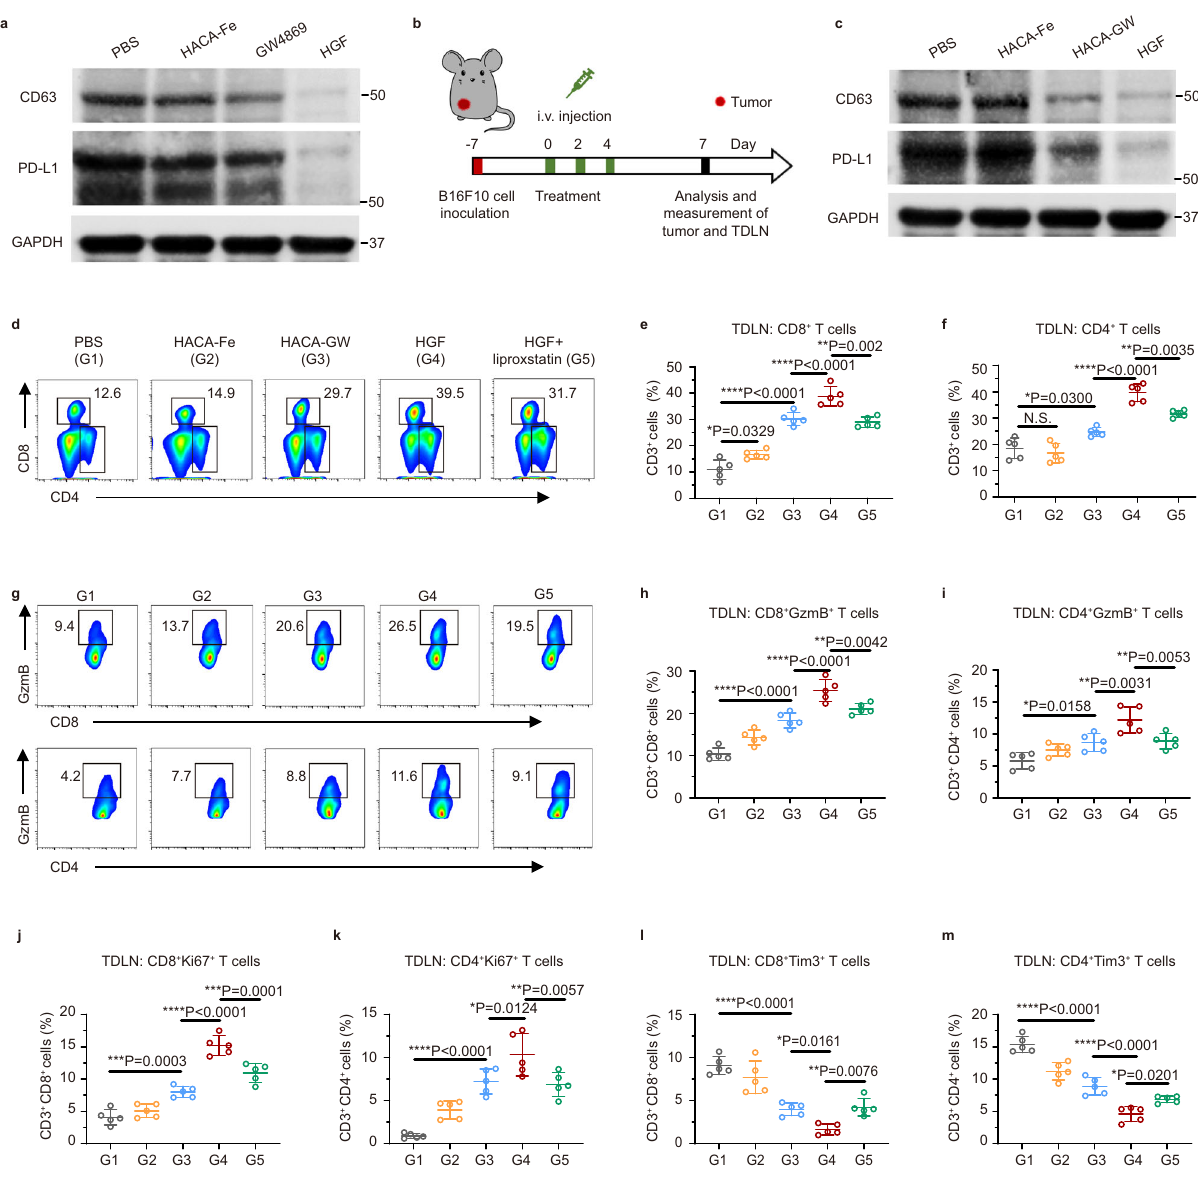
Fig. 3 HGF NPs inhibited exosomal PD-L1 and triggered robust immunostimulation. a Western blot analysis of exosome marker CD63 and PD-L1 via collecting the exosomes from the cell-free media of B16F10 cells with various treatments. GAPDH served as a loading control. Images were representative of the three experiments. b Scheme of in vivo experimental design for ( c – m ). C57BL/6 mice were subcutaneously inoculated with 1 × 10 6 B16F10 cells. When tumor volumes reached ~ 100 mm 3 , mice were treated with PBS, HACA-Fe, HACA-GW, or HGF on day 0, day 2, and day 4. Tumor and tumor- draining lymph node (TDLN) were collected on day 7 for further analysis. c Western blot analysis of exosome marker CD63 and PD-L1 in tumor tissues after treatment. Images were representative of the three experiments. d – f Flow cytometric plots ( d ) and quanti fi cation of CD8 + ( e ) and CD4 + ( f ) T cells, respectively, gated by CD3 + T cells in the TDLN ( n = 5) in groups of PBS (G1), HACA-Fe (G2), HACA-GW (G3), HGF (G4), and HGF + liproxstatin (G5). g – m Flow cytometric analysis of granzyme B + (GzmB + , g - i ), Ki67 + ( j and k ), and Tim3 + ( l and m ) in CD8 + and CD4 + T cells. n = 5 biologically independent animals per group. Data were presented as mean ± SD. Statistically signi fi cant differences between groups were identi fi ed by one-way ANOVA with Tukey ’ s post hoc test. * P < 0.05, ** P < 0.01, *** P < 0.001, and **** P <